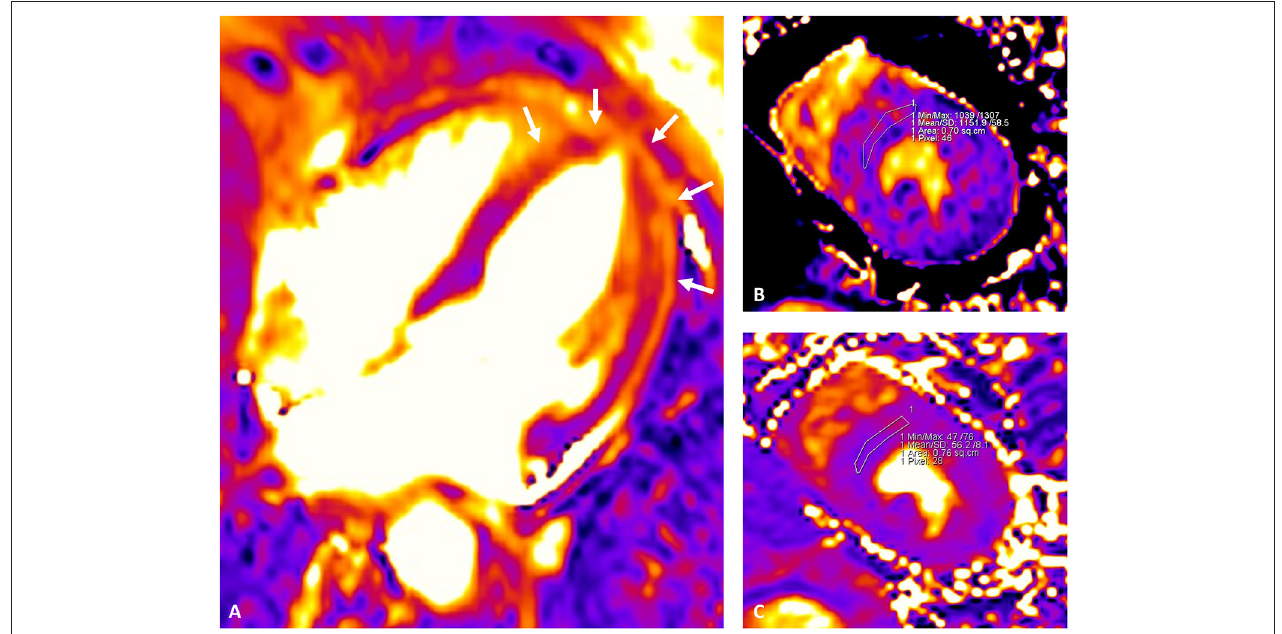
FIGURE 4 | Cardiac magnetic resonance mapping images depicting myocardial edema in the acute phase of TTS. Mid-apical circumferential edema of the left ventricle is visualized as areas of higher intensity from the T2 mapping image (white arrows in A ). Parametric quantification of native T1 and T2 values is better performed from the mid short-axis view by drawing a conservative region of interest (ROI) within the interventricular septum. Native T1 (MOLLI) (B) and T2 (C) shows a parallel increase at 1,152 and 56ms, respectively. Extra-cellular volume (ECV) fraction was calculated from native and post-contrast T1 mapping images (mid-slice, short-axis, interventricular septum ROI) and hematocrit level as described in the literature (64), resulting elevated at 31%. The examination was performed with a 1.5T scanner (Siemens Aera, Erlangen, Germany); in-center upper reference of normality for the sequence and vendor used are as follow: native T1 995ms; native T2 49ms, ECV